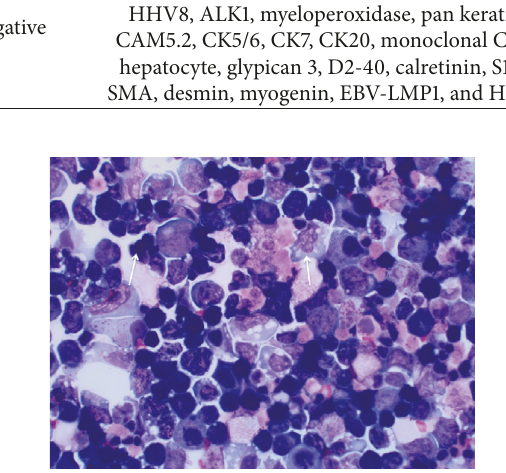
Figure1:AsciticfluidcytologywithDiff-Quickstaindemonstrating largeatypicallymphocyteswithroundtoanaplasticnuclei,dispersed chromatin, and basophilic cytoplasm (marked by the arrows). A subset of cells show plasmacytoid/plasmablastic morphology.